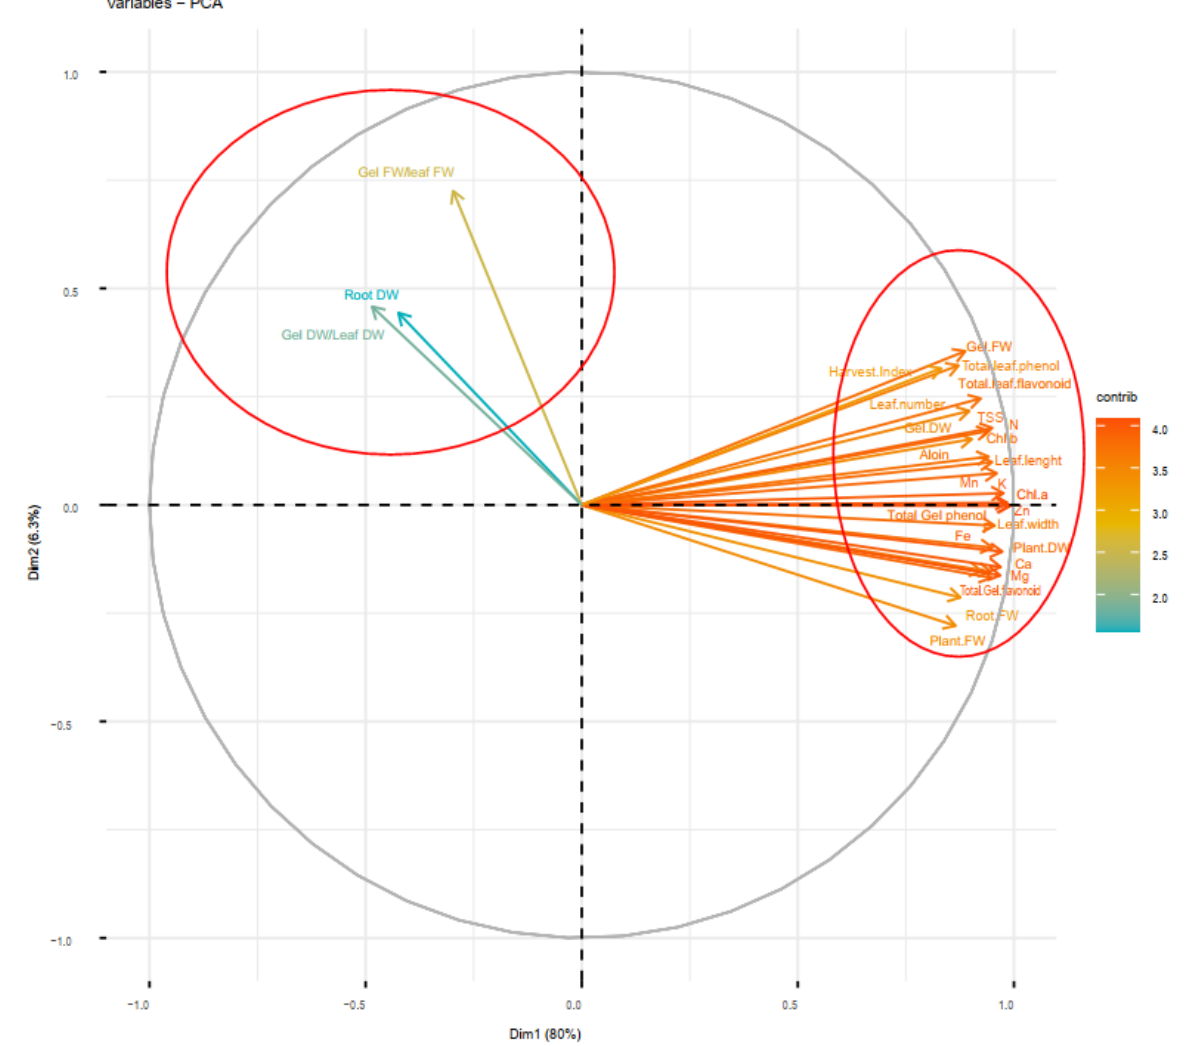
Figure 9. Principal component analysis (PCA) of soil-based animal manure and foliar applications (distilled water, salicylic acid, cerium oxide nanoparticles, and CeO 2 : SA-nanoparticles) on the growth, physiological responses, and elemental content of Aloe vera L. plants. FW and DW refer to fresh and dry weight, respectively.